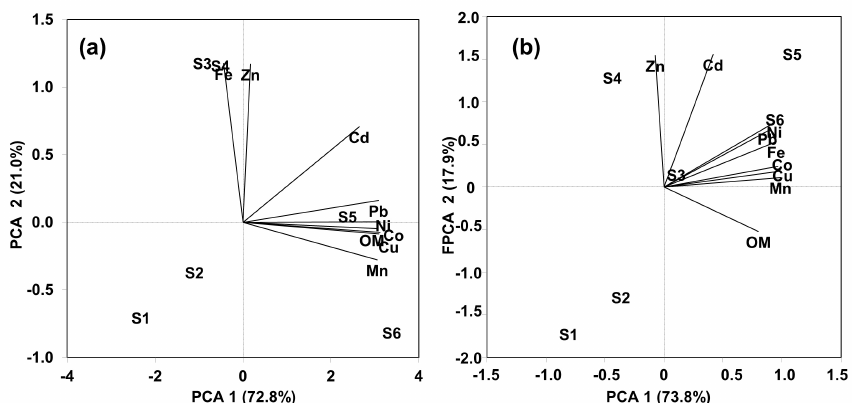
Figure 4. Plot of the first two principal components obtained from the PCA of toxic trace metal concentrations in Damietta branch sediments during the summer ( a ) and winter ( b )